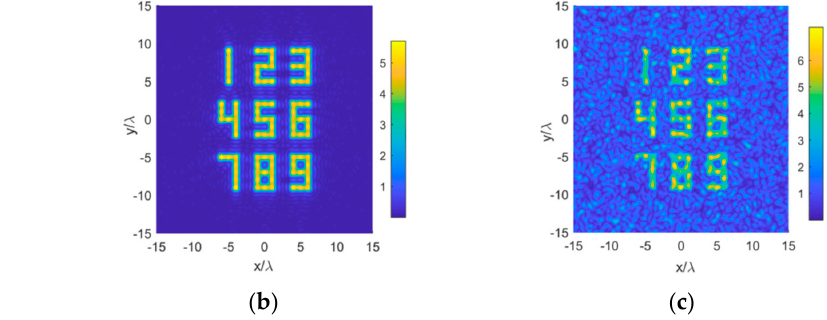
Figure 8. The reconstructed pictures of source Case 3. ( a ) no noise; ( b ) SNR = 30 dB WGN; ( c ) SNR = 0 dB WGN.